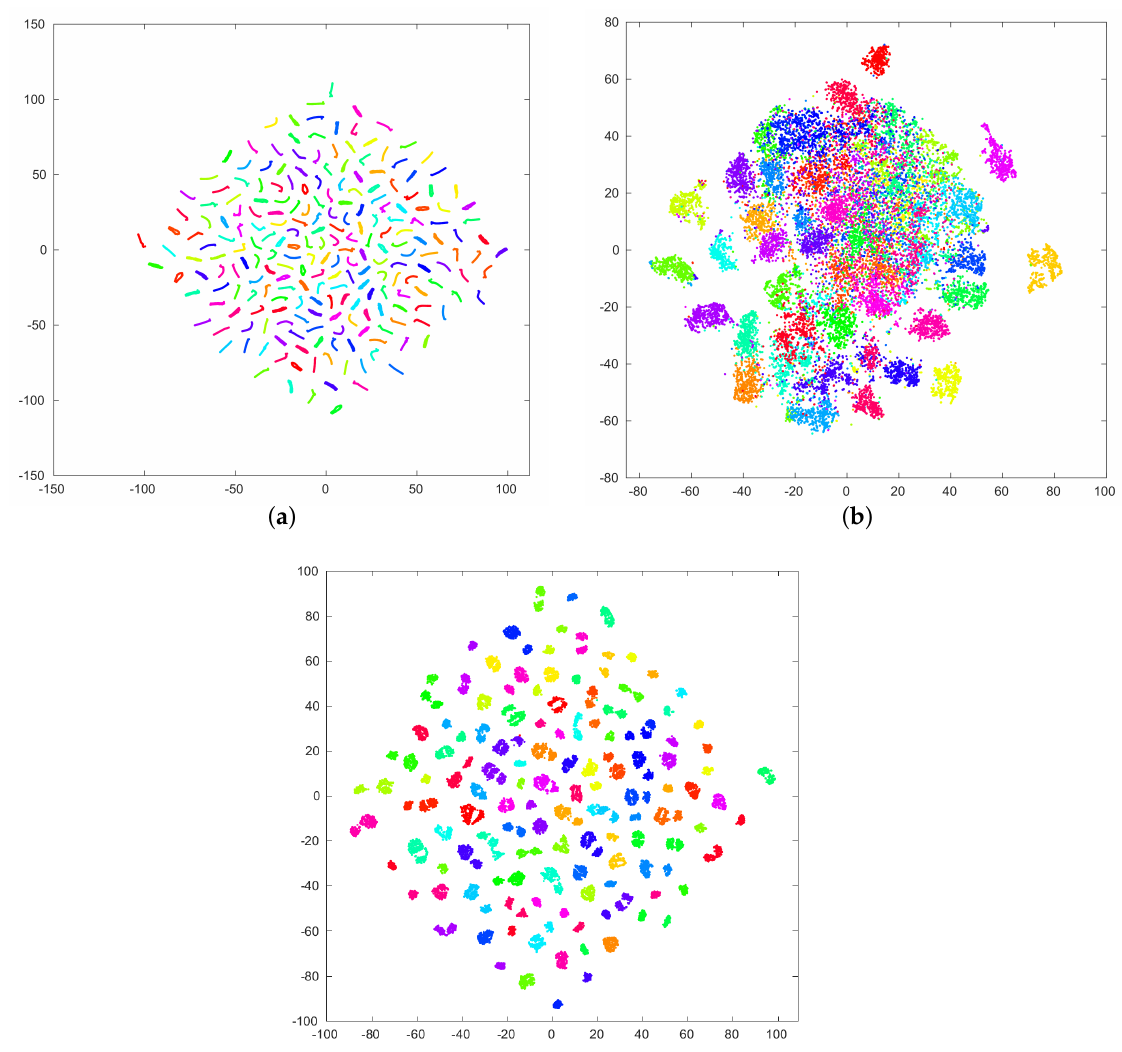
Figure 4. Two-dimensional visualization results of scene features for images in NWPU-RESISC45 dataset. In this paper, t-SNE was used to map shallow features, high-level features, and shallow and high-level features into 2D